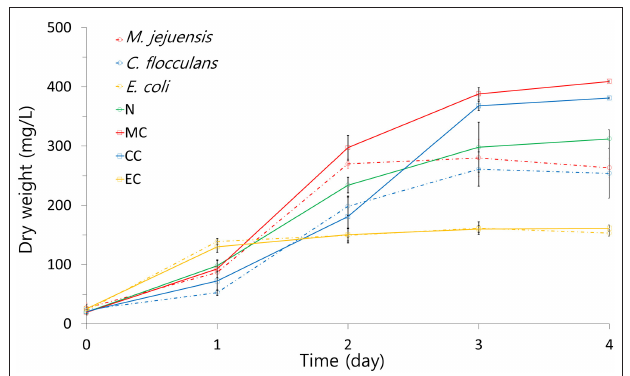
FIGURE 3 | The growth pattern of each culture condition was visualized using dry weight. MC, M. jejuensis and C. sorokiniana ; CC, C. flocculans and C. sorokiniana ; EC, E. coli and C. sorokiniana ; N, C. sorokiniana only, control group. Marked characteristics are annotated in Supplementary Figure 1 .